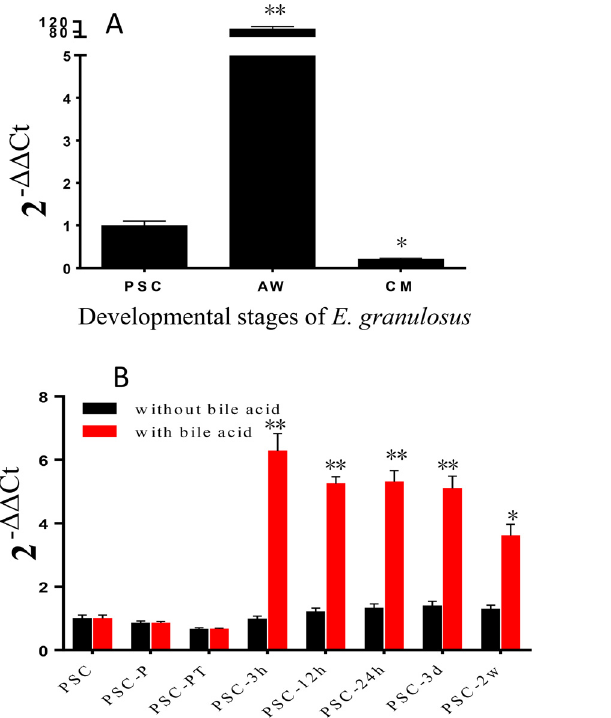
Figure 6. Quantitative real-time PCR analysis of the tran- scription of EgHR3. The transcription of EgHR3 in different developmental stages of E. granulosus : AW, adult worms; CM, cyst germinal layer (A). The transcription of EgHR3 at different time points of cultured E. granulosus protoscoleces (B). PSCs, protoscoleces; PSC-P: PSCs treated with pepsin; PSC-PT: PSCs treated with pepsin and trypsin; PSC-B3h, PSC-B12h, PSC- B24h: PSCs treated with pepsin and trypsin then cultured with sodium taurocholate for 3, 12, and 24h; PSC-B3d: PSCs treated with pepsin and trypsin then cultured with sodium taurocholate for 3days; PSC-B2w: PSCs treated with pepsin and trypsin then cultured with sodium taurocholate for 2weeks. The data were normalized using the housekeeping gene Eg-eif . * , signi fi cant difference compared with the expression level in PSCs.